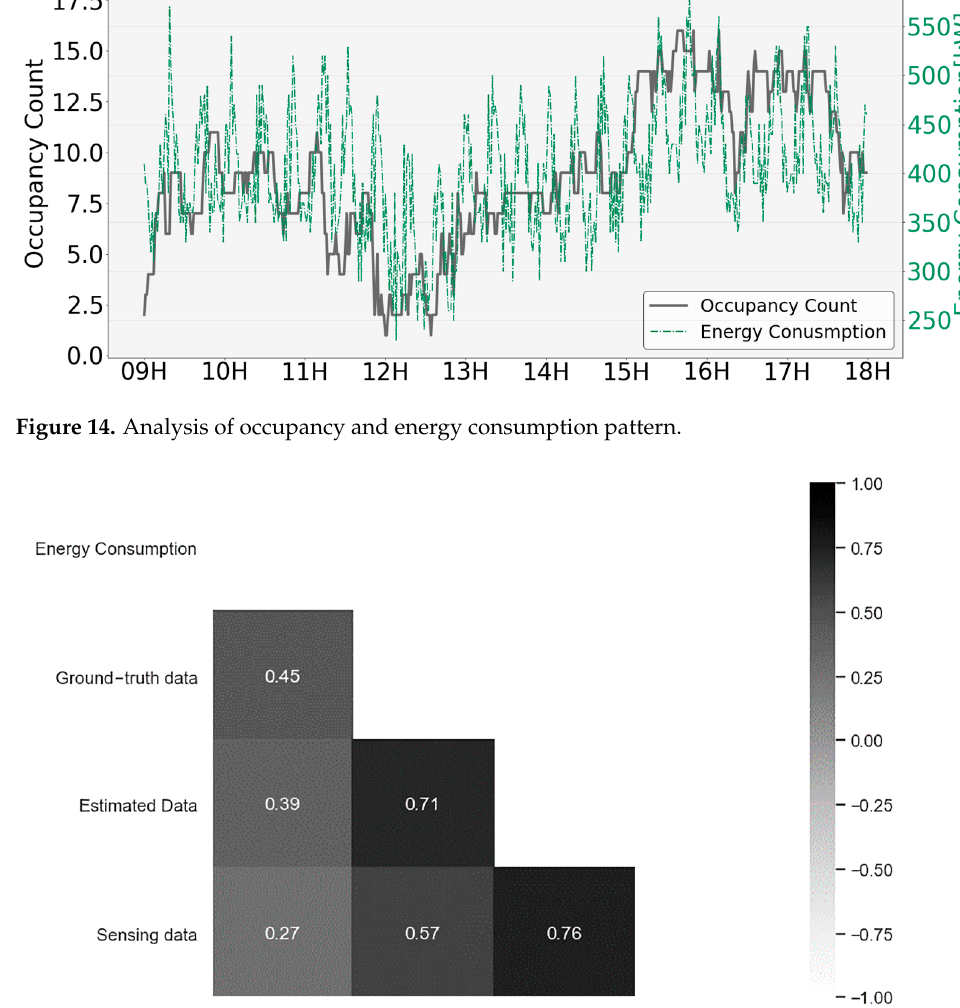
( b ) Figure 13. Analysis of occupancy count error distribution between sensing and estimated data: ( a ) occupancy distribution in room 1; ( b ) occupancy distribution in room 2. 3.3. Prediction of Energy Consumption 3.3.1. Analysis of Energy Consumption In this section, the occupancy (ground-truth, sensing, and estimated data) and energy consumption presented in Phase 3 are analyzed. The occupancy count was calculated by integrating rooms 1 and 2, considering that the energy consumption levels were connected to each other. Figure 14 shows the occupancy of the ground-truth data and energy con- sumption collected at a time interval of a minute. The green solid line represents the en- ergy consumption data and the solid black line represents the occupancy count. Energy consumption increased for a certain period (approximately 30 min) and then decreased,